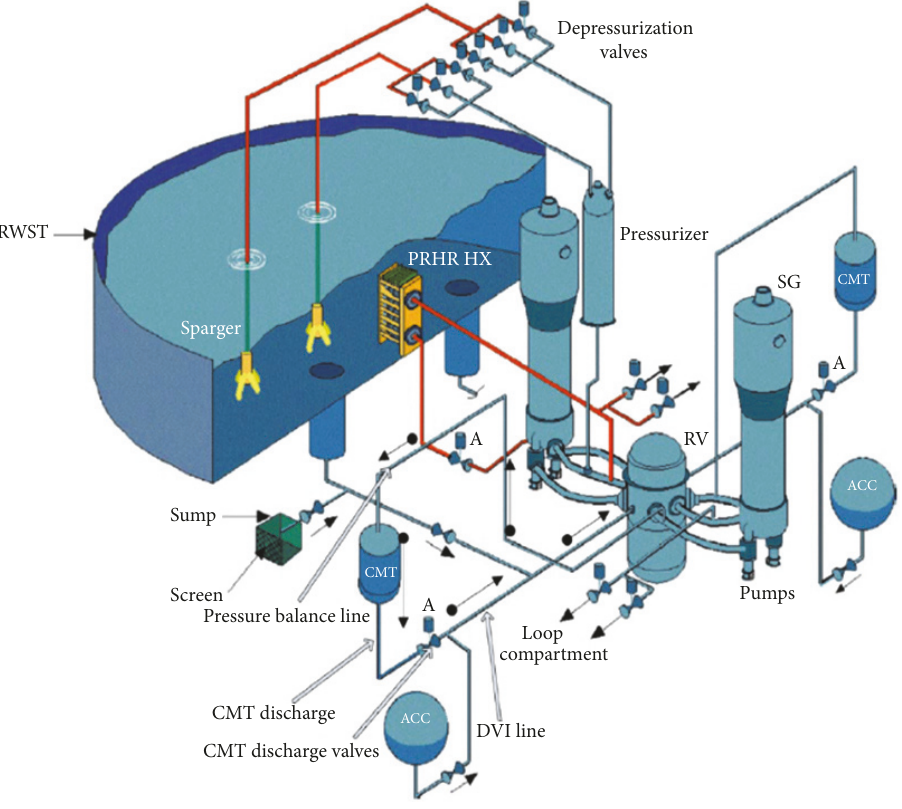
Figure 1: AP1000 passive core cooling